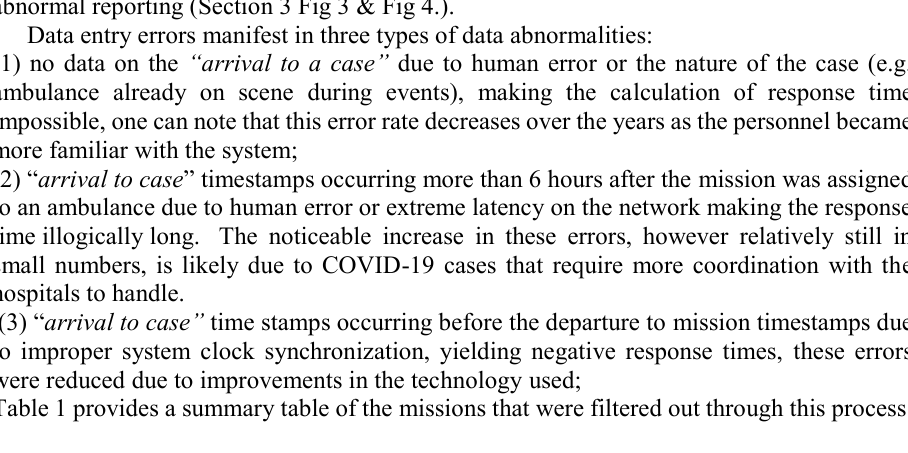
Table 1. Filtered-out Raw Data and Response Times